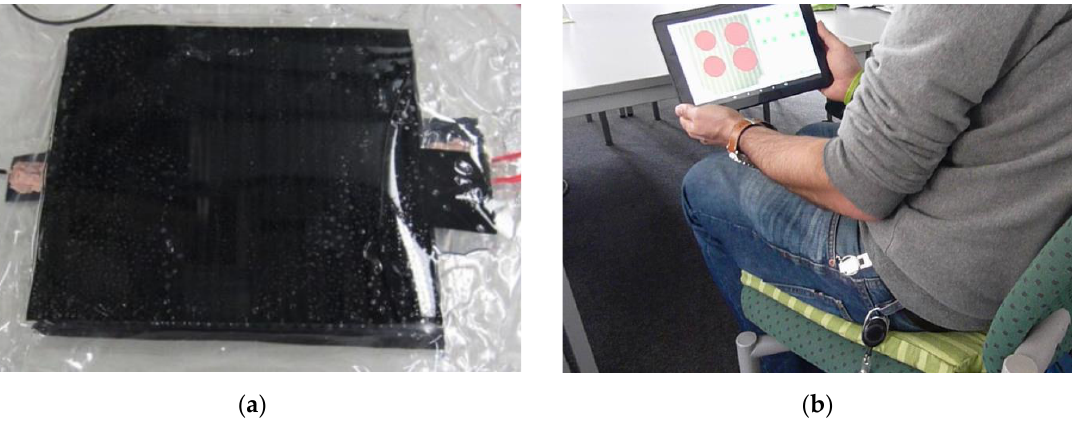
Figure 18. DE pressure sensor for seat applications ( a ) and demonstration of monitoring the weight distribution of a person on a chair cushion with four sensors ( b ) [100].